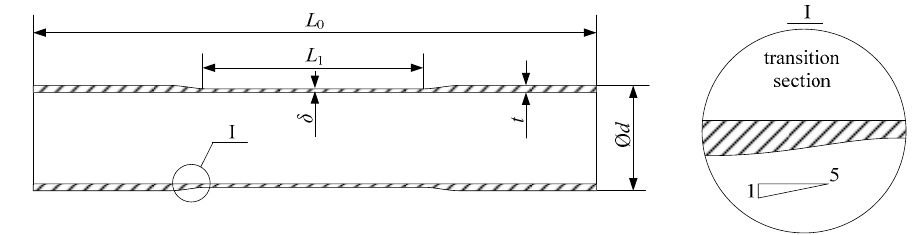
Figure 3. The thinned tubular specimen of Inconel 690.